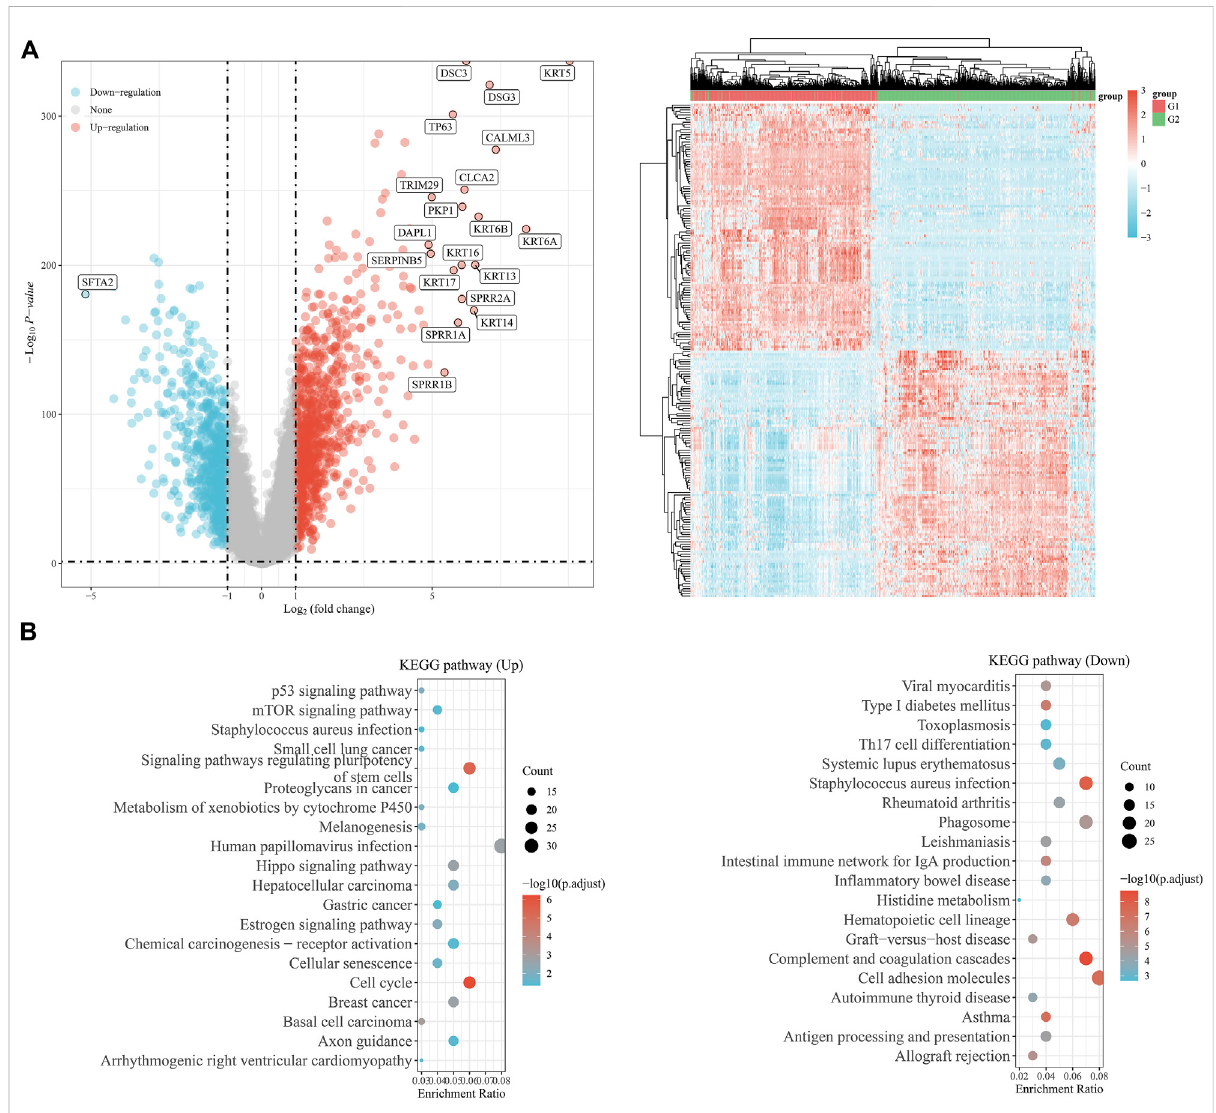
FIGURE 4 Function enrichment analysis of EMT clusters and the identi fi cation of tumor-suppressor SFTA2. (A) The graphs show the differentially expressed genes in the C1 and C2 groups, with up-regulated genes in red and down-regulated genes in blue. (B) We performed functional enrichment analysis to show the pathways involved in differentially up-regulated and down-regulated genes in the KEGG database.